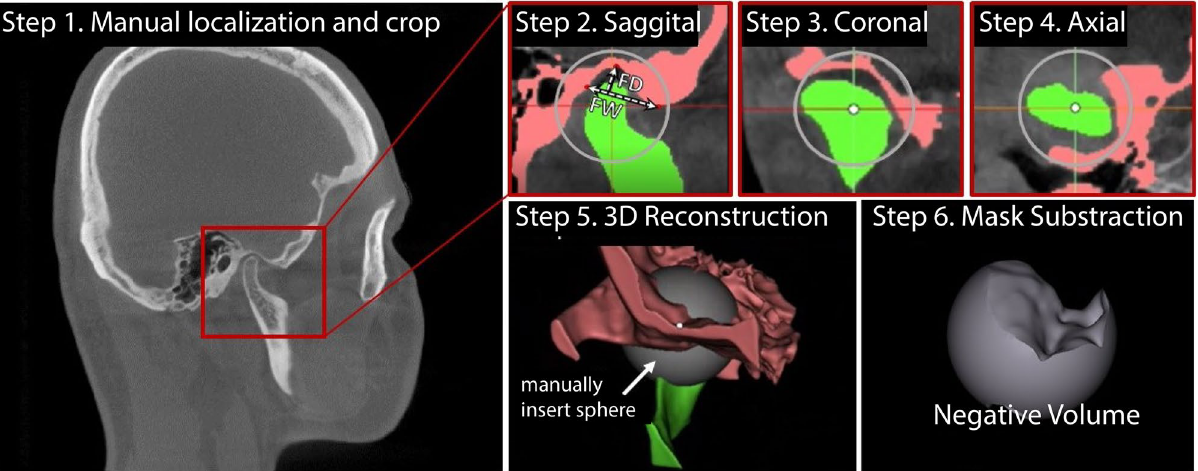
Figure 1. Proposed steps for manual negative volume annotation in TMJ (left to right). The process requires drawing masks around complex structures of mandibular condyle (green) and temporal bones (red) in all three views (saggital, coronal, and axial) for each slice of the volume of interest (VOI), until the resulting 3D reconstruction allows to subtract the negative “ball” from a manually inserted sphere. Such annotation takes about 1 hour per patient . Figure created with Incscape v.1.1, https:// inksc ape.